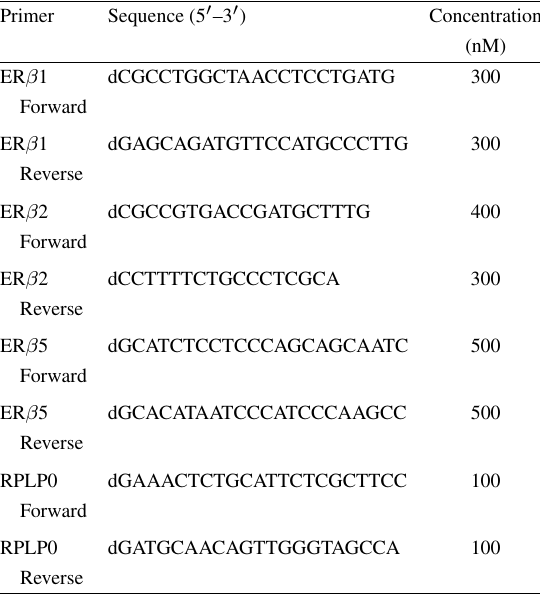
Sequences and optimised primer concentrations of ER β isoform- specific and RPLP0 reference gene qRT-PCR primers